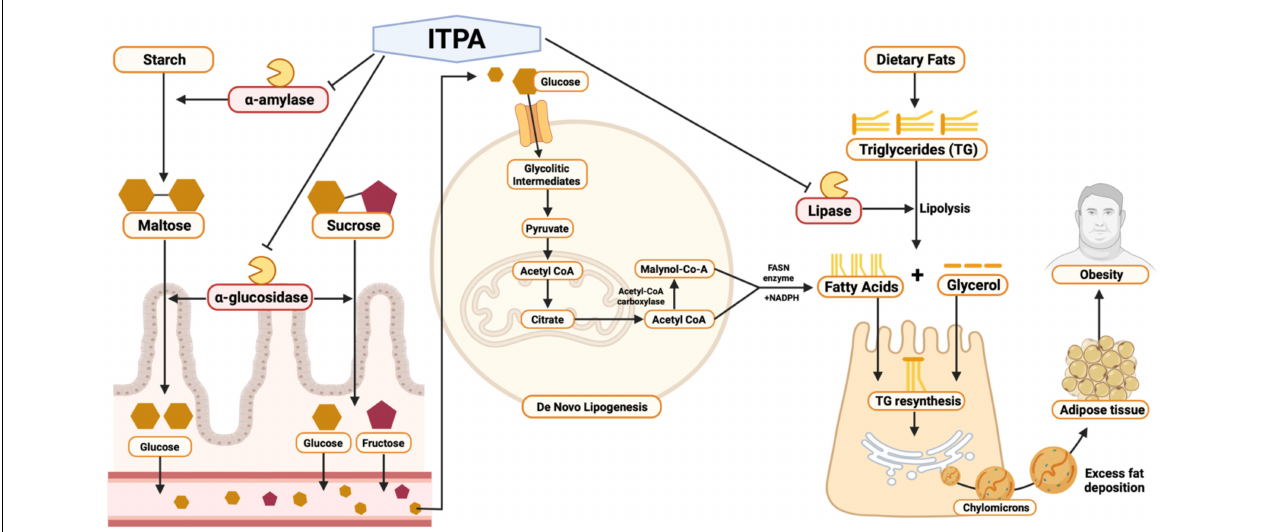
FIGURE 4 | Pharmacological mechanism of sea grapes ( Caulerpa racemosa ) extract by in silico and in vitro studies.